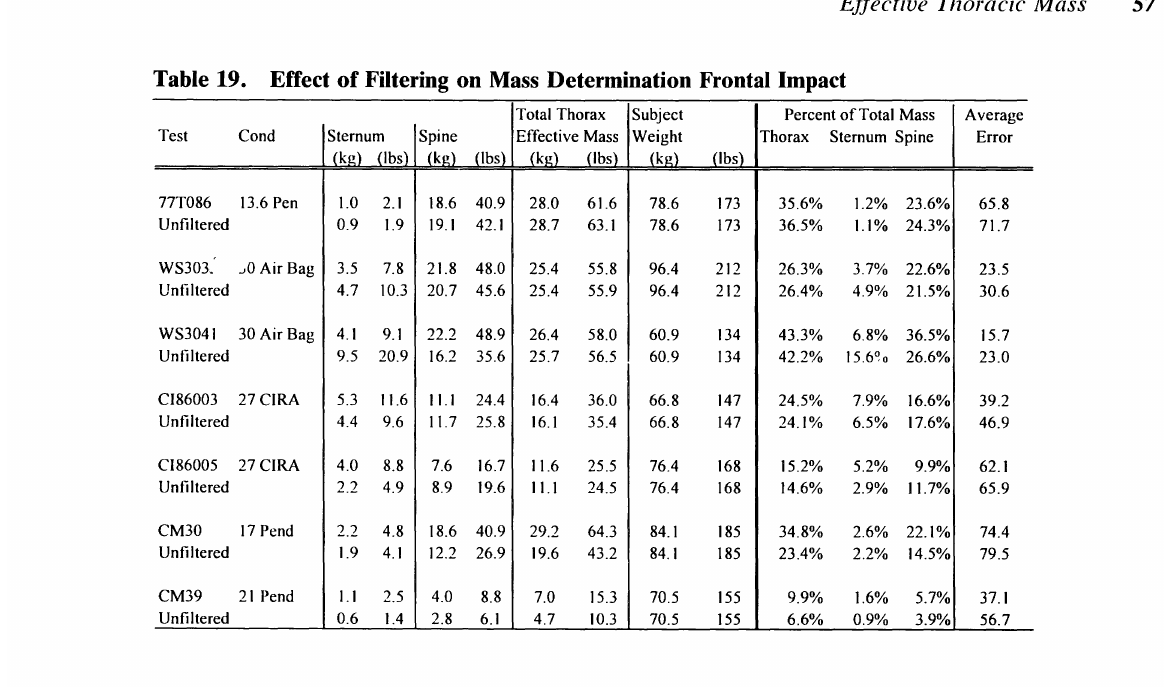
Table 19. Effect of Filtering on Mass Determination Frontal